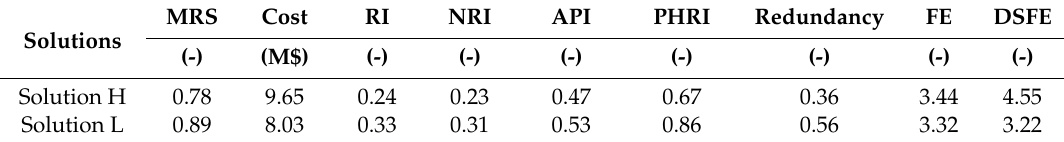
Table 4. Comparison of two representative solutions for the HAN problem.